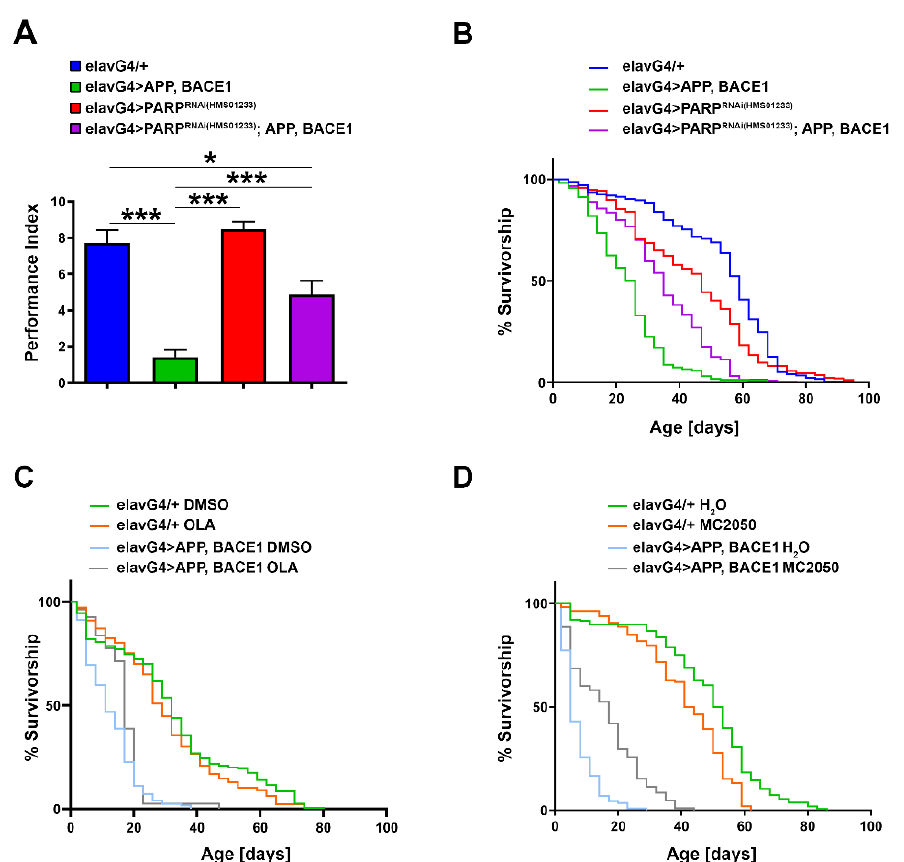
Figure 9. ( A ) Climbing test on AD APP/BACE1 flies with neuron-specific depletion of PARP-1 by RNAi. Statistical significance was determined using the one-way ANOVA test followed by the Tukey test for multiple comparisons (** p < 0.01; *** p < 0.001). ( B ) Survival curves of AD APP/BACE1 flies with neuron-specific depletion of PARP-1 by RNAi and related controls. The log-rank (Mantel–Cox) test with Bonferroni correction for multiple comparisons indicates a significant difference between all survival curves (*** p < 0.001). ( C ) Survival curves of AD APP/BACE1 flies treated with 25 µM olaparib and related controls. The log-rank (Mantel–Cox) test with Bonferroni correction for multiple comparisons indicates a significant difference between all survival curves (** p < 0.01) except for elav-Gal4/+ DMSO vs. elav-Gal4/+ OLA. ( D ) Survival curves of AD APP/BACE1 flies treated with 50 µM MC2050 and related controls. The log-rank (Mantel–Cox) test with Bonferroni correction for multiple comparisons indicates a significant difference between all survival curves (*** p < 0.001).